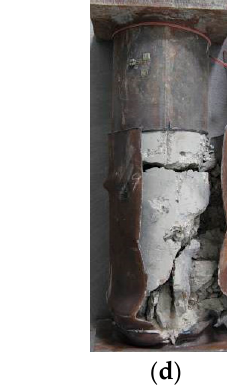
Figure 6. Typical photographs of the core concrete after failure. ( a ) CSC1-3; ( b ) CSC2-2; ( c ) CSC2-4; ( d ) CSC3-2.